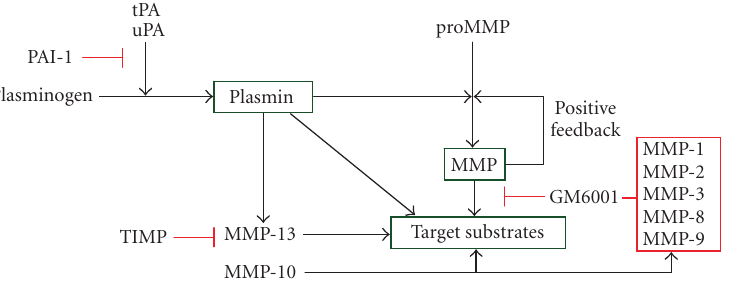
Figure 1: tPA and uPA convert plasminogen to the active, broad-spectrum, protease plasmin both at the cell surface and in the immediate pericellular space. Plasmin, in turn, degrades target substrates (eg, APP, Aβ ) directly as well as indirectly through downstream activation of matrix metalloproteinases (MMPs). Inhibition of MMP activity (GM6001, TIMP) has confirmed their participation in plasmin-initiated proteolysis. Most importantly, this cascade is e ff ectively attenuated by overexpression (or exogenous addition) or PAI-1 which blocks tPA and uPA catalysis inhibiting, thereby, plasmin